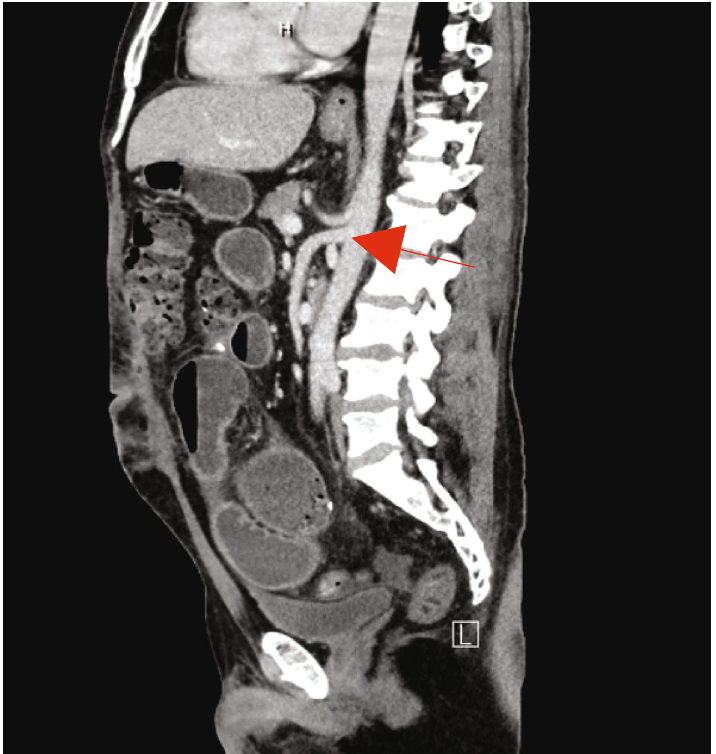
Figure 3: Contrast-enhanced CT demonstrating patent superior mesenteric and celiac